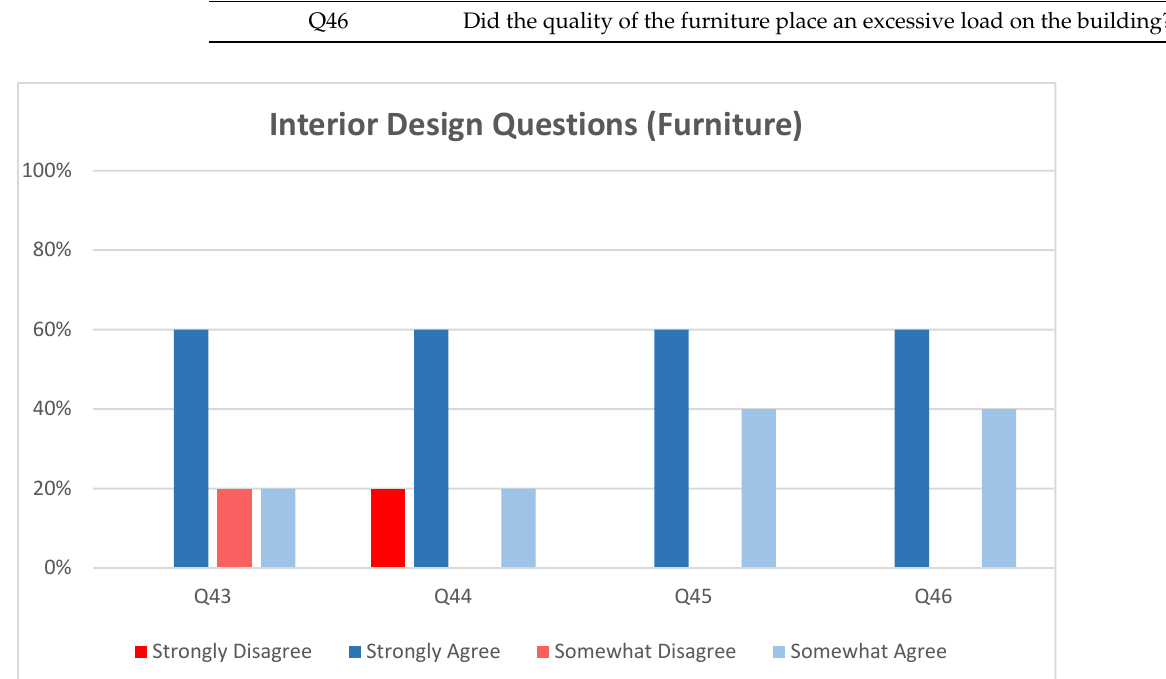
Figure 12. Results of the questions on furniture .